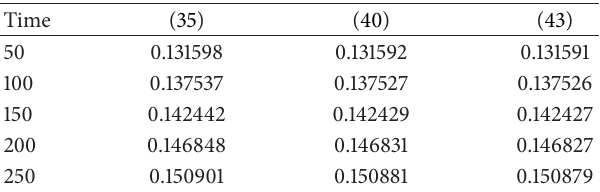
Table 7: Table showing max 𝑢(𝑥, 𝑡) for each of the schemes where 𝛼 = 2